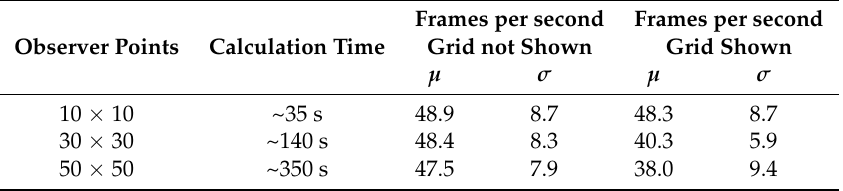
Table 1. Startup time, as well as mean and standard deviations in frame rate for different sizes of the precomputed noise data grid on an Oculus Go 64GB, for ten source points. Loading the application, map, and city model takes about 20 s; the rest of the startup time is due to noise